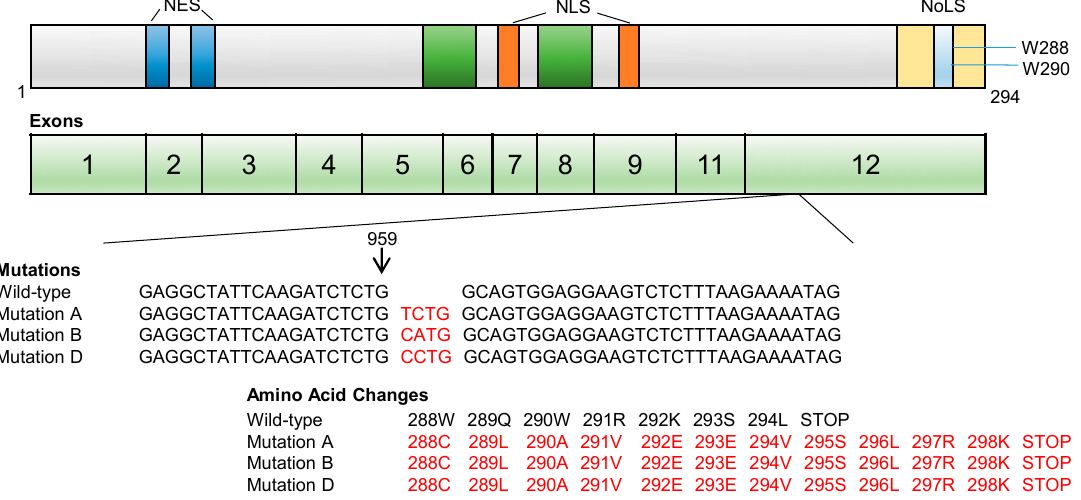
Figure 2. NPM1 gene structure and common mutations in AML. Gene structure with exons 1–12 shown in addition to the sequence of the three most frequent exon 12 mutations/insertions in AML. These insertions lead to amino acid changes which affect the nucleolar localization signal (NoLS) (yellow) and cause the translocation of NPM1 from the nucleus to the cytoplasm. Nuclear export system (NES) (blue) and nuclear localization signal (NLS) (orange).